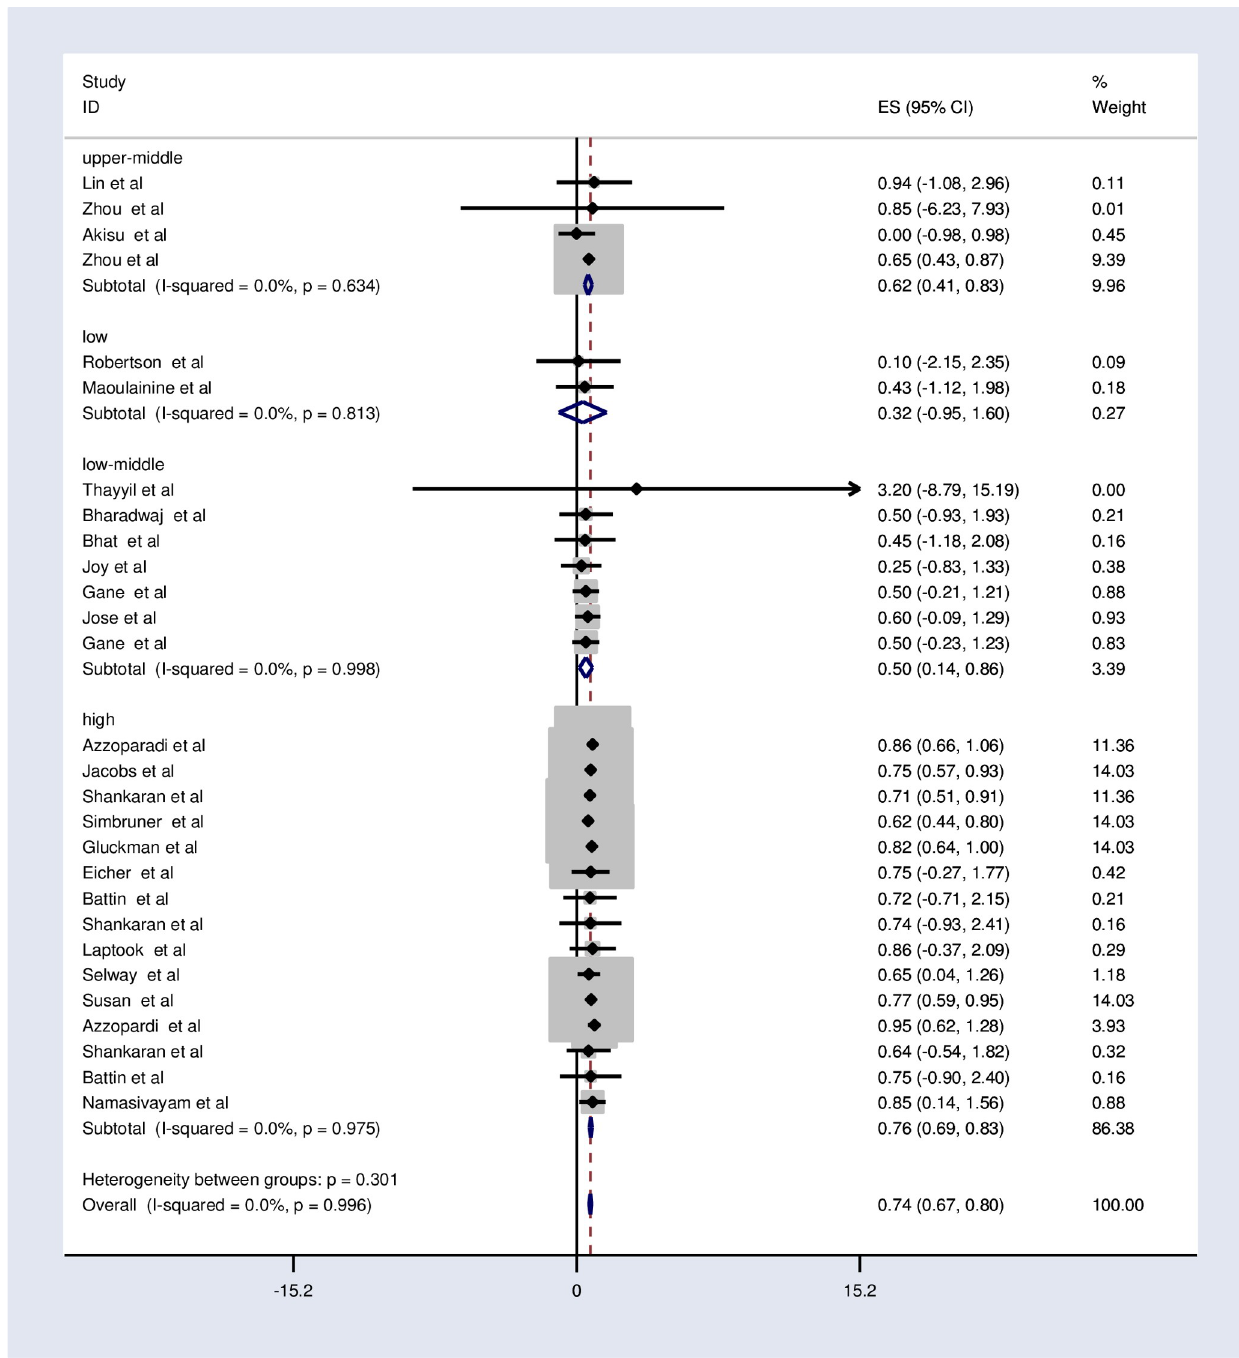
Fig 3. Subgroup analysis by the country level of income on the effects of therapeutic hypothermia on death among asphyxiated neonates with hypoxic-ischemic encephalopathy.